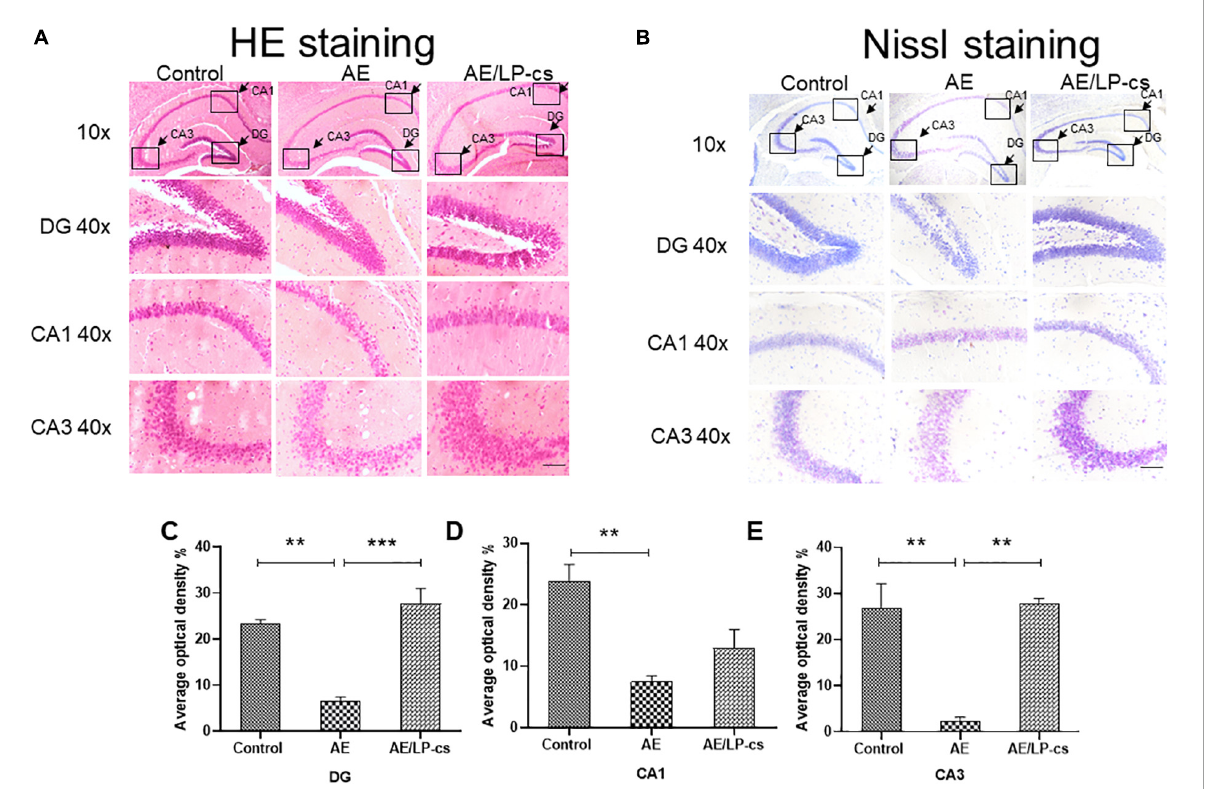
FIGURE2 Lactobacillus plantarum culture supernatants ameliorates alcohol-induced changes in hippocampus morphology. (A) The H&E staining of the hippocampus from mice. (B) Nissl staining of the hippocampus from mice (scale bar, 15 µ m). (C–E) The average optical density value of Nissl bodies was quantified by ImageJ 6.0 software. Control vs. AE and AE vs. AE/LP-cs, * p < 0.05, ** p < 0.01, *** p < 0.001, n =